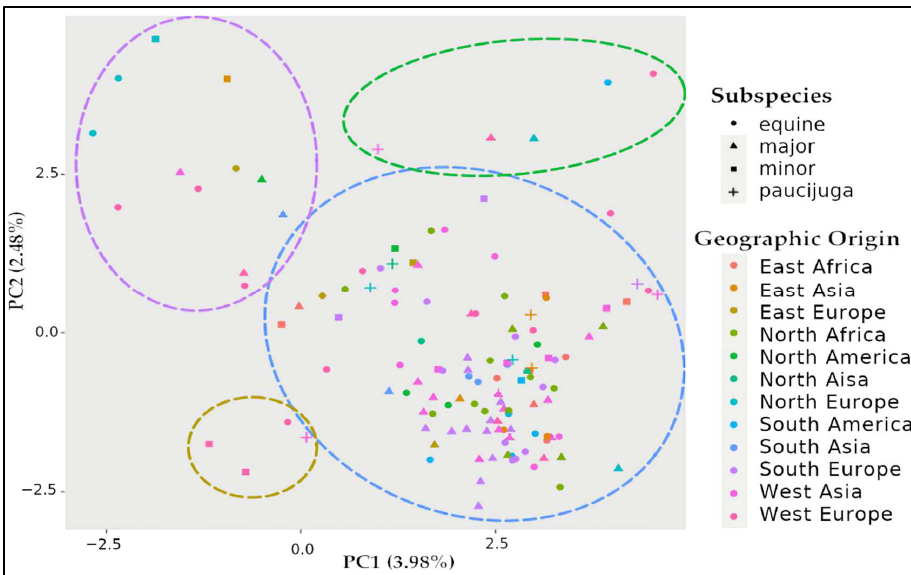
Figure 1. Scatterplot of principal component analysis scores of components 1 and 2 of faba bean panel. PCA was estimated in TASSEL and represented in R. Genotypes are identified by color according to their geographic origin and shape according to their subspecies. Potential clusters of genotypes are indicated by colored circles.